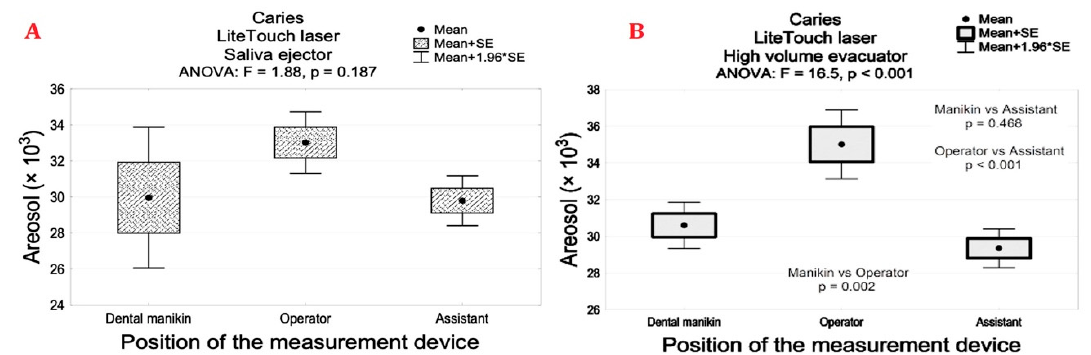
Figure 7. The level of aerosol particles (×103) measured at the manikin’s, operator’s, and assistant’s mouths for the LightTouch Er:YAG laser with ( A ) salivary ejector and ( B ) high-volume evacuator. (Mean(SD)) during tooth/caries’ preparation.